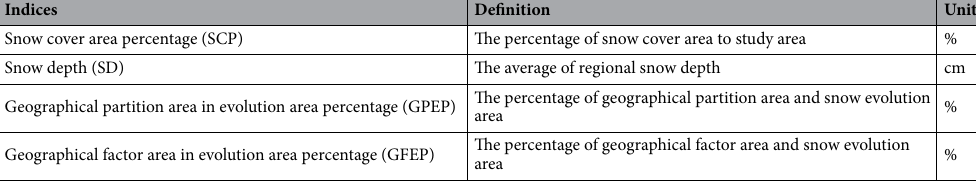
Table 3. Snow parameters index and its